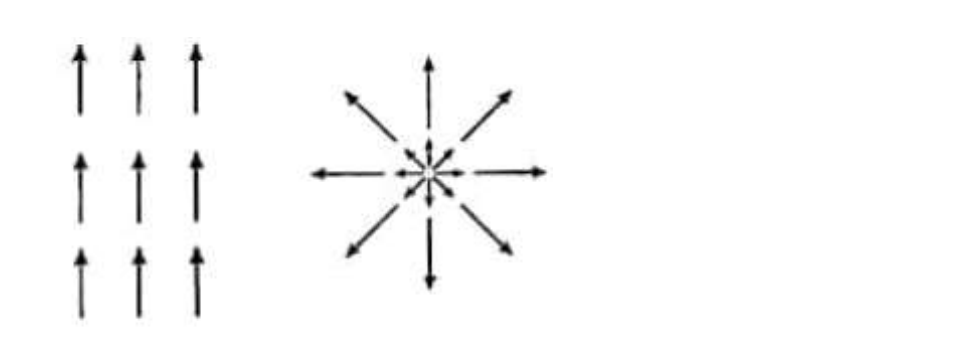
Figure 8. An illustration of the cosmological principle. The figure describes how homogeneity and isotropy of space are related.